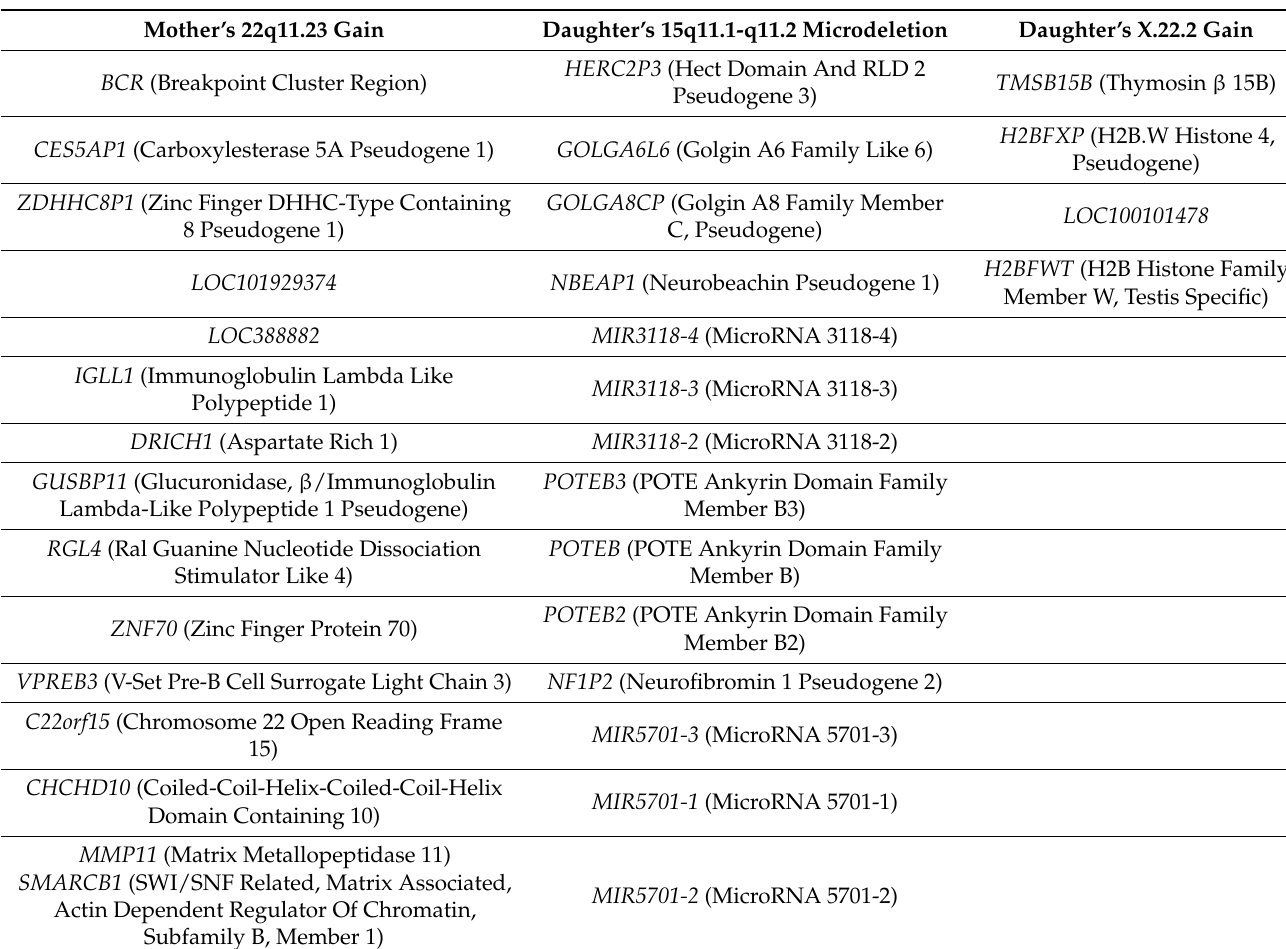
Table 2. The list of genes subjected to copy number variations (CNVs) resulting from the mother’s 22q11.23 chromosomal gain, the daughter’s 15q11.1-q11.2 microdeletion and the daughter’s X.22.2 chromosomal gain. Mother’s 22q11.23